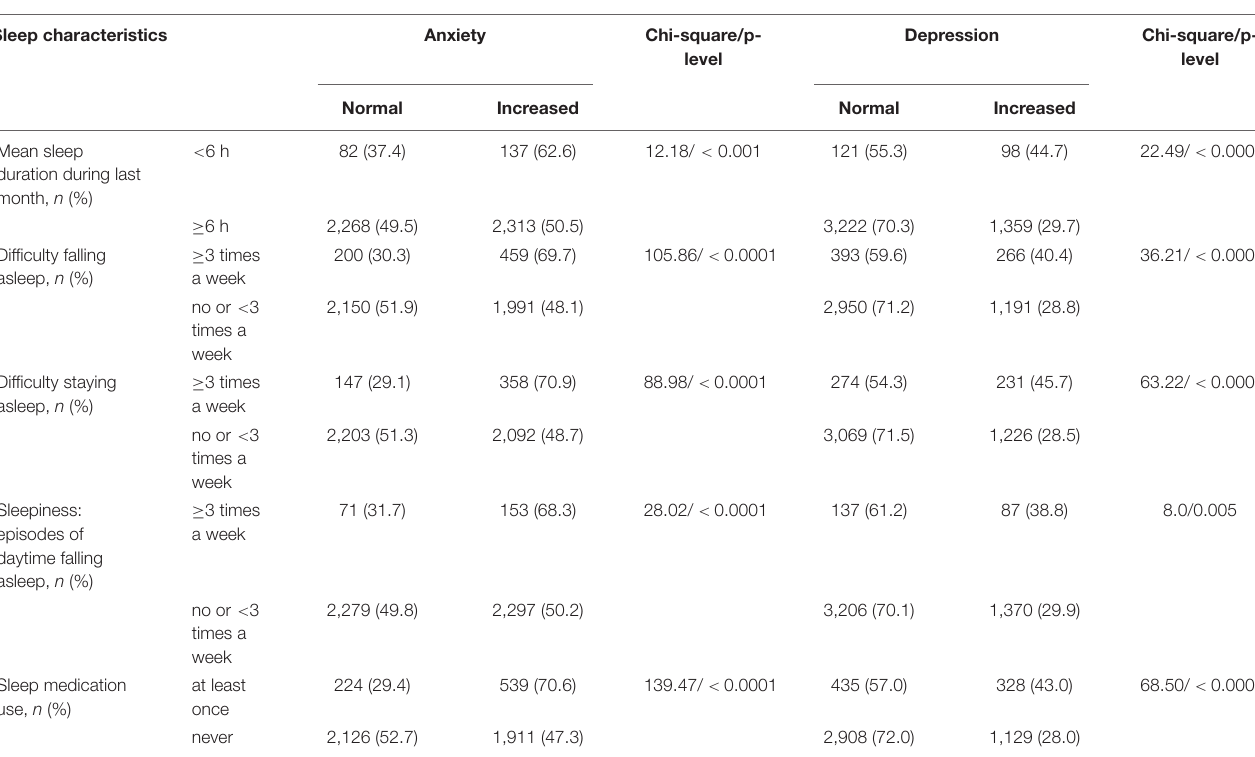
TABLE 5 | Sleep characteristics, anxiety, and depression. Anxiety Depression Chi-square/p-